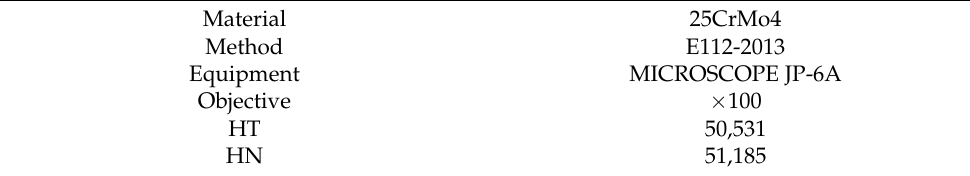
These results were obtained under the experimental conditions presented in Table 9. Table 9. The experimental conditions for determining the austenitic grain index for 25CrMo4 [1].